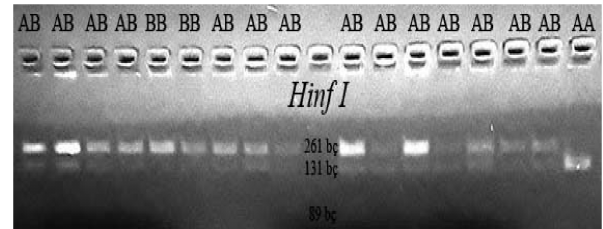
Figure 2. PCR-RFLP cut regions of the CSN3 gene: BB (261/89bp), AA (131/89bp) AB (261/131/89bp).